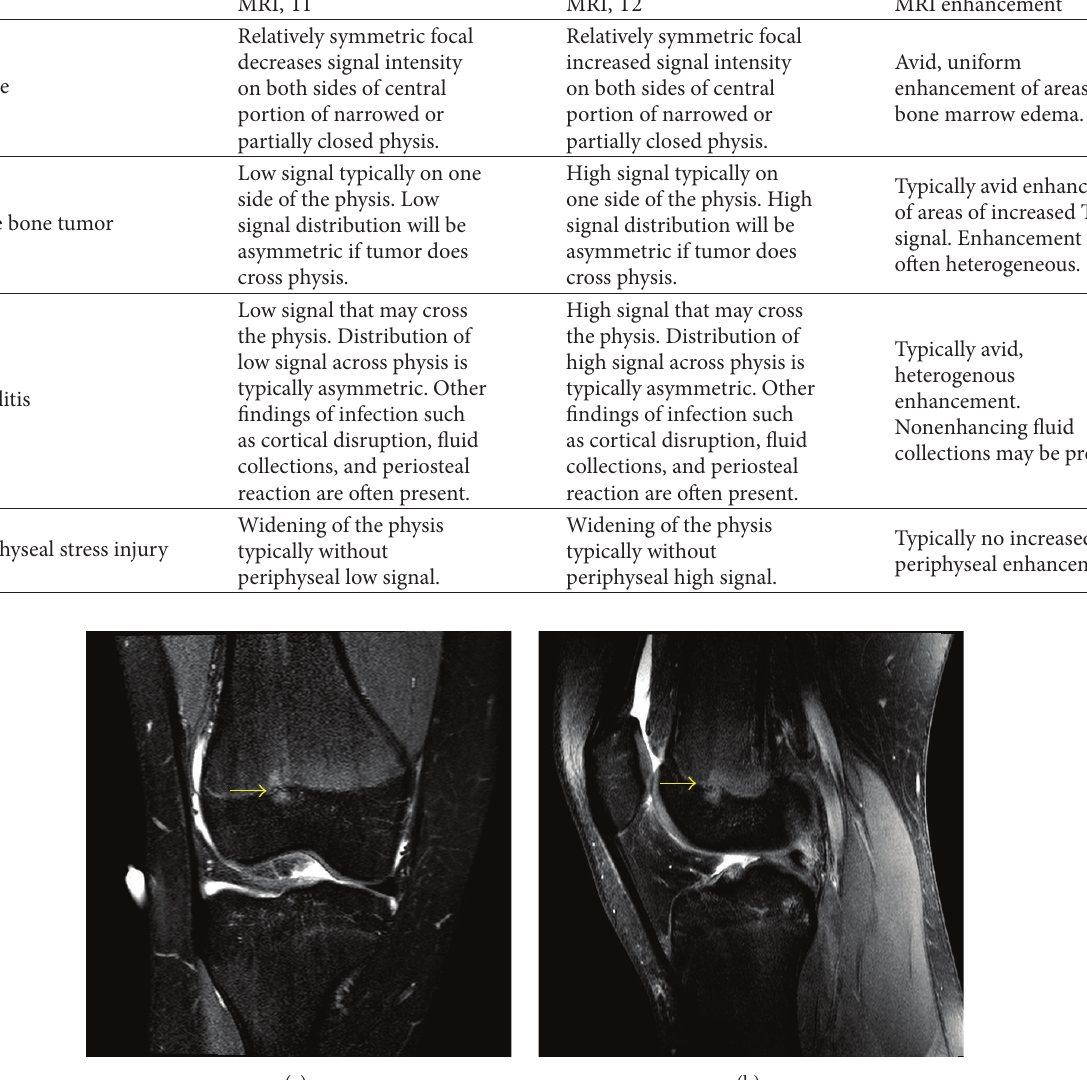
Table 2: Differential diagnosis MRI characteristics.